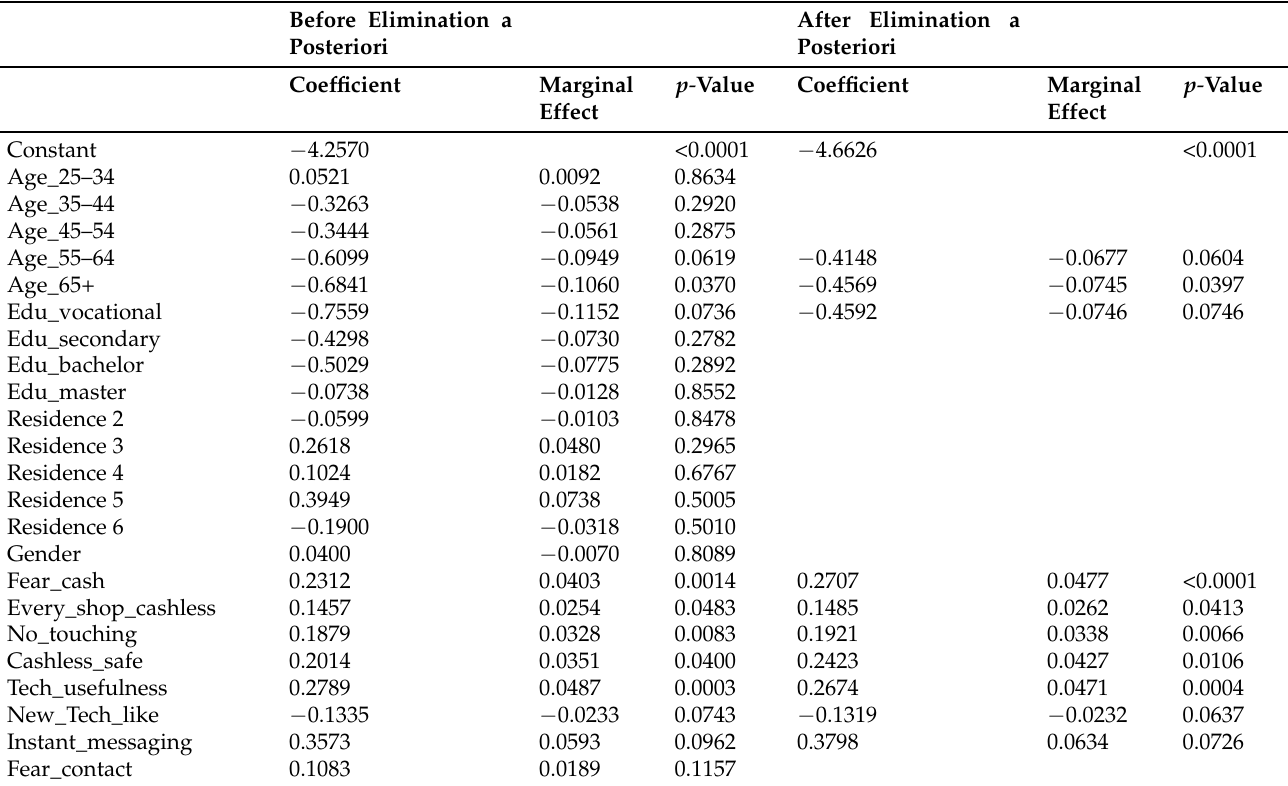
Table 6. The results of the estimated logit model before and after elimination a posteriori ( n = 1000).